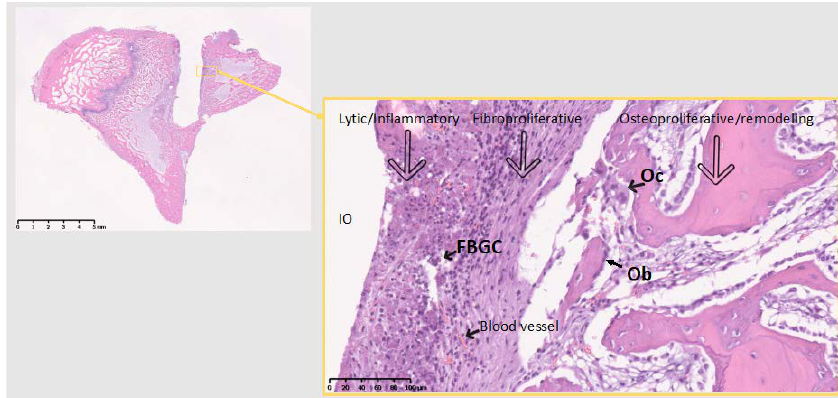
Figure 5. The 10 days Ti site. Bone remodeling and new bone formation around the implant site, isolating it from the marrow space. Scale bars, clockwise: 5 mm, 500 µm and 50 µm.